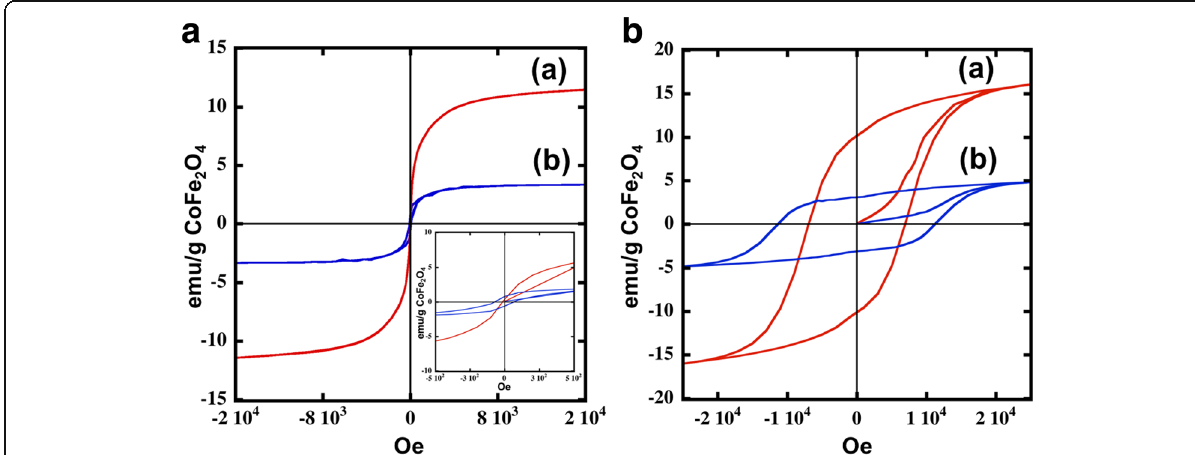
Fig. 4 Hysteresis loops for nanoparticles: ( a ) and ( b ) are for the CoFe 2 O 4 nanoparticles (red line) and CoFe 2 O 4 @Ag nanoparticles (blue line), respectively, at a 300 K and b at 5